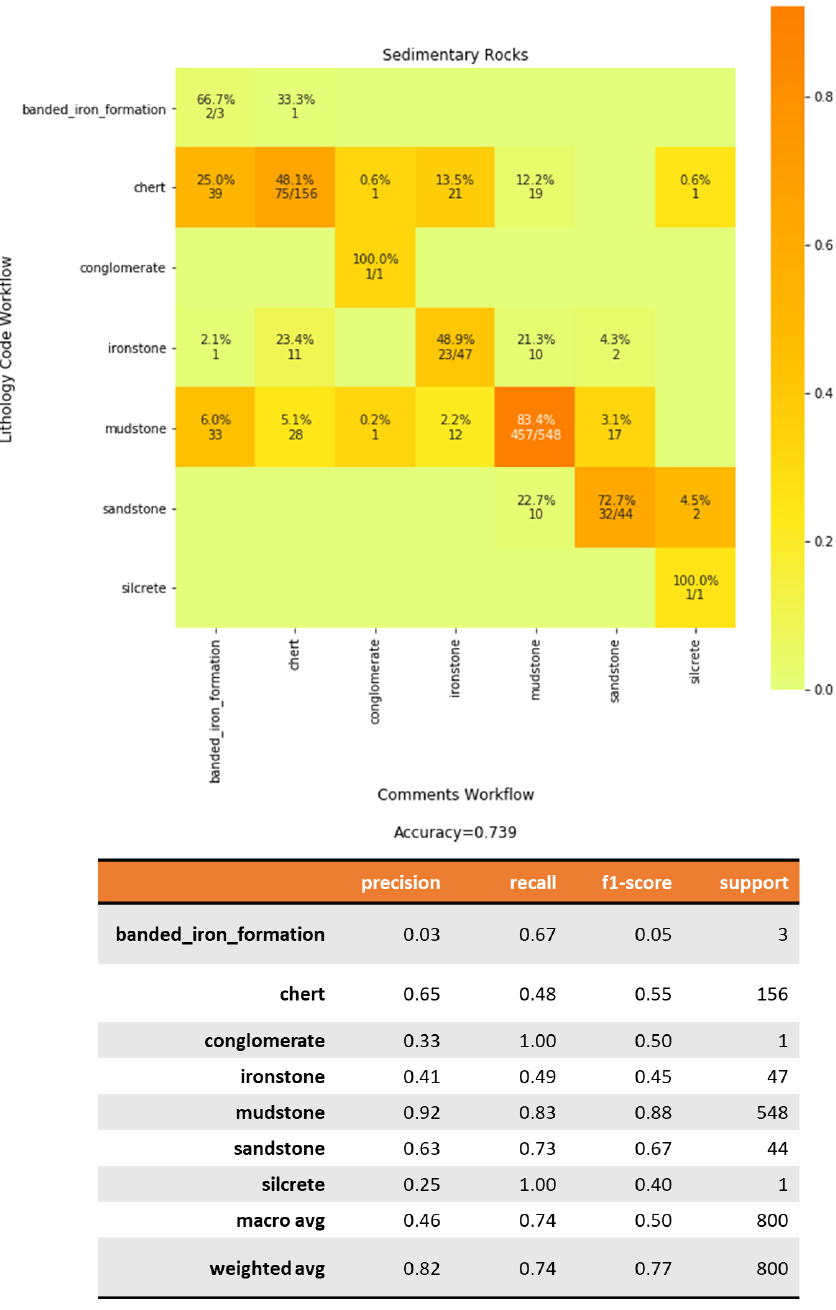
Figure 9. Confusion matrix for sedimentary rocks comparing the fuzzy string matching results from the Lithology Code workflow (vertical axis) and Comments workflow (horizontal axis). The heatmap shows the values normalized to the support size to address the imbalance between classes. The values shown in the cells indicate the number of samples classified for the class. Empty cells indicate zero